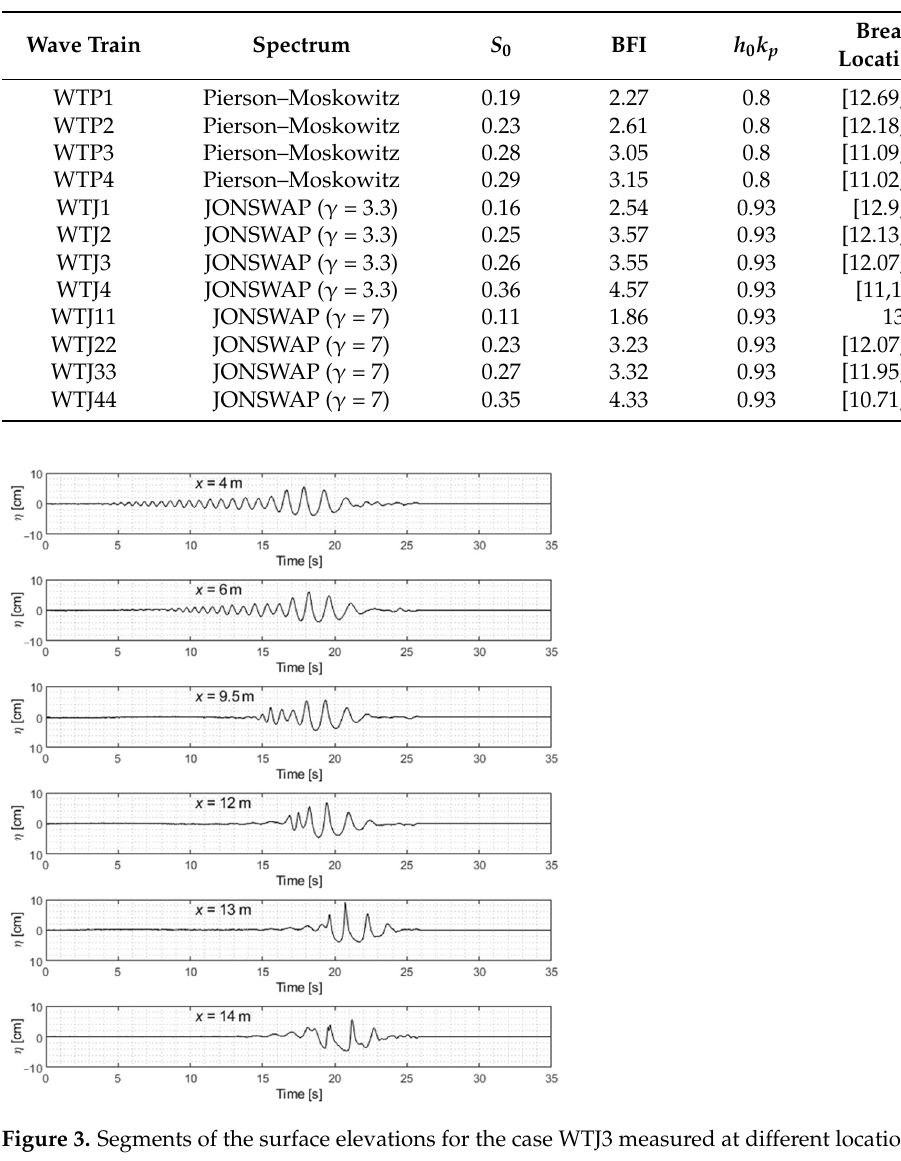
Figure 3. Segments of the surface elevations for the case WTJ3 measured at different locations along the wave flume. x = 9.5 m is the toe of the slope.